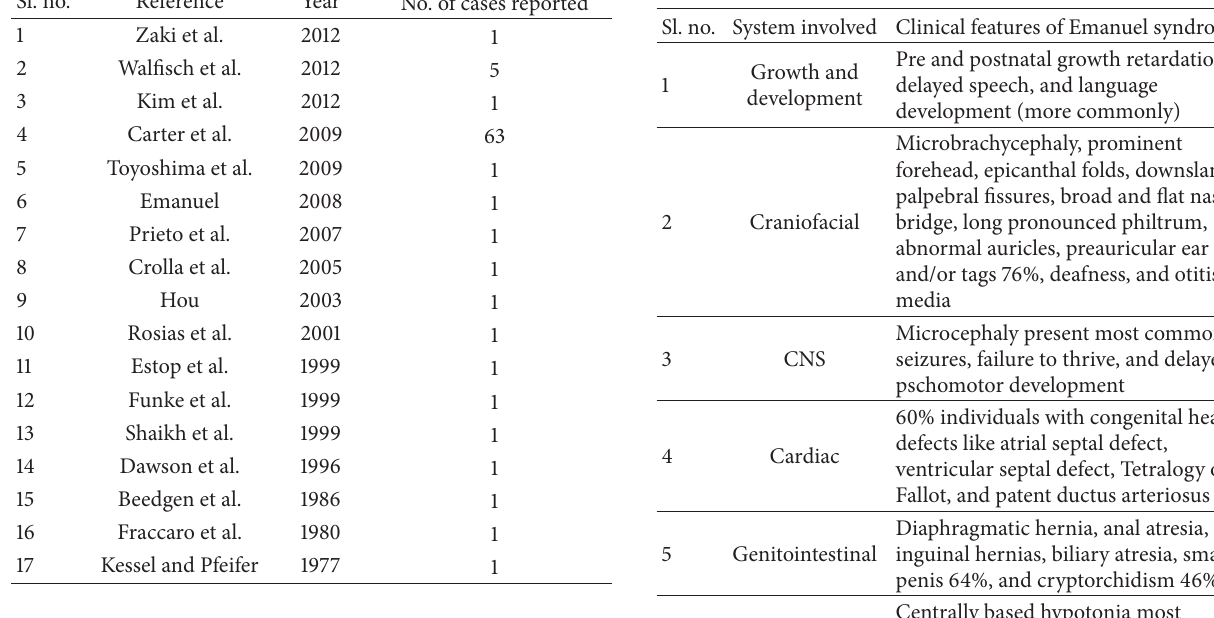
Table 2: List of clinical features observed in Emanuel syndrome [3, 4, 14,